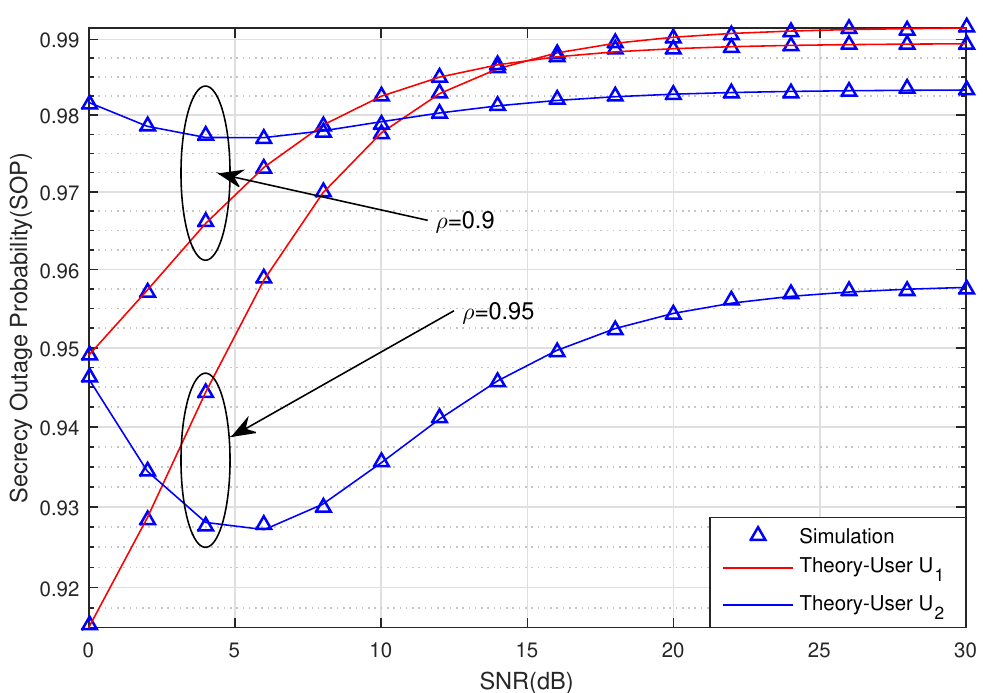
Figure 3. The SOP of U 1 and U 2 versus SNR (dB) when ρ = 0.9 and ρ =